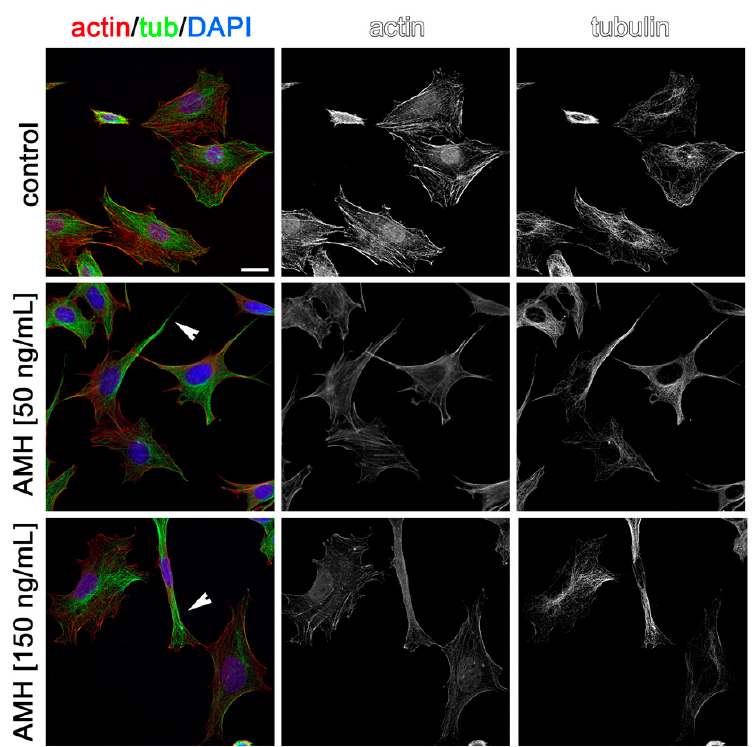
Figure 5. Anti-Müllerian hormone (AMH) treatment alters GN11 cytoskeleton organization. GN11 cells treated with AMH (at 50 and 150 ng/mL) were immune-labeled for F-actin (red) and α -tubulin (green) to reveal microfilament and microtubule organization, respectively. Single channels are shown as black and white images. Arrowheads point at cells displaying a prominent fusiform morphology. Scale bar: 25 µm.